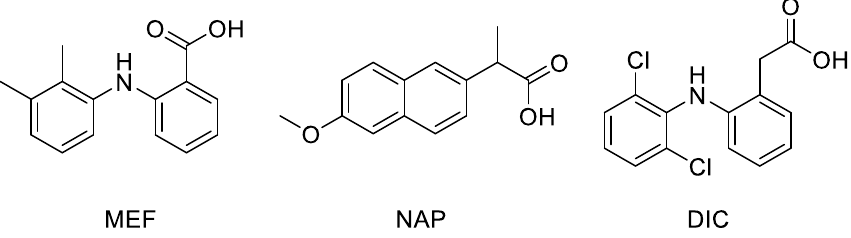
Figure 3. Chemical structure of crystallographic ligands MEF, NAP, and DIC complexed with COX-2 enzyme (PDB code 5IKR, 3NT1, and 1PXX, respectively).